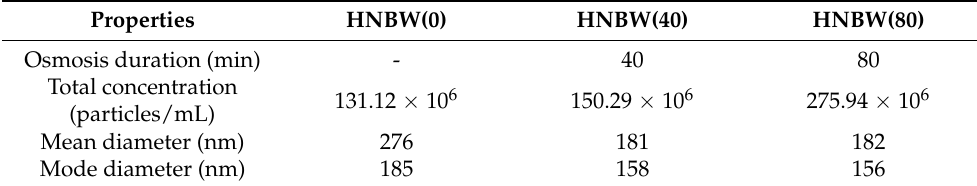
Figure 4. Size distribution of nanobubbles according to high densification. Nanobubbles with a diameter of 200 nm or less are gradually increasing, and this section is marked with a blue background. Table 2. NTA test results of HNBW according to osmosis duration.